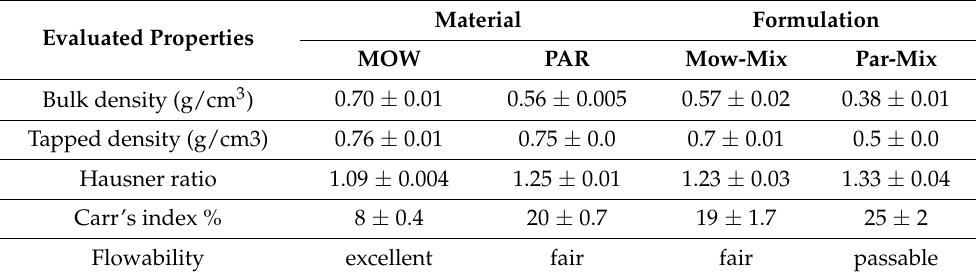
Table 2. Evaluation of flow properties by means of Hausner ratio and Carr’s